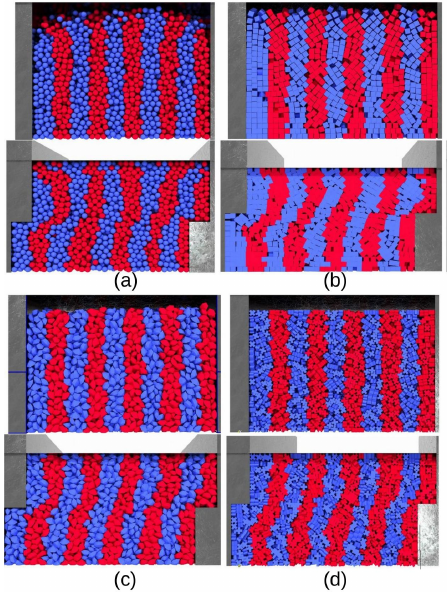
Figure 7. Cross sectional front view image at of unbound and final states ( P conf 50 kPa) (a) sphere, (b) cube , (c) Snome and (d) CrossP particle shapes.